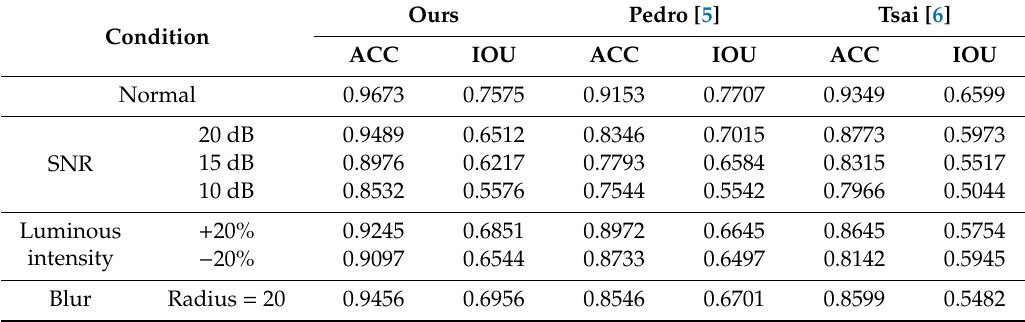
Table 1. Experimental results with di ff erent